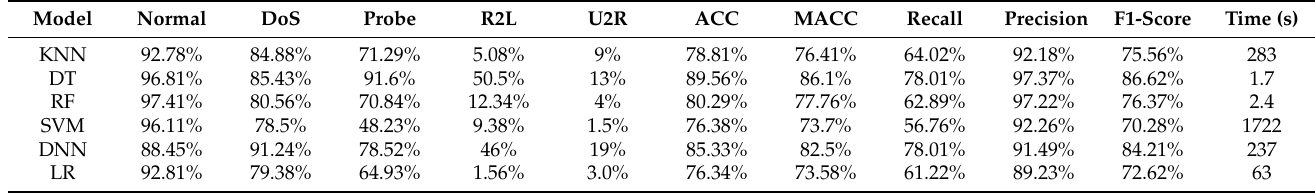
Table 6. Detection performance for different classifiers based on the NSL-KDD testing+.